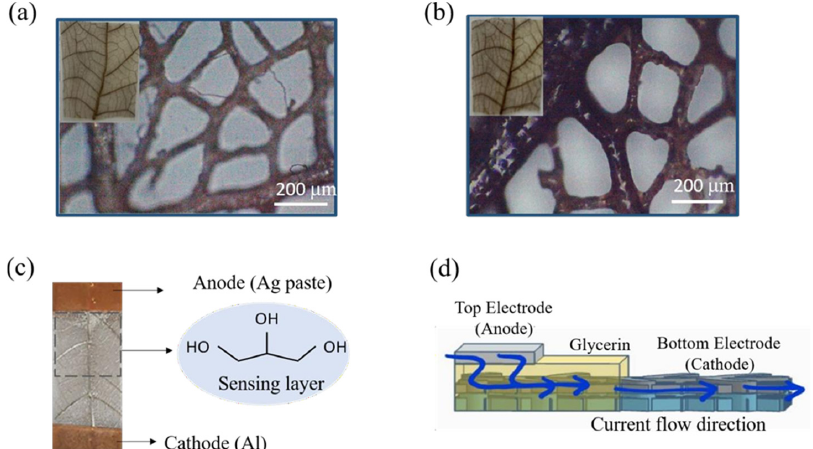
Figure 2. ( a , b ) Optical Microscopy (OM) images of the leaf vein networks before and after thermal annealing (80 °C/1 h). The inset images represent pristine leaf veins and leaf vein with sensing film (after thermal annealing). ( c ) Photo of final structure leaf vein-based sensor. ( d ) Schematic side view structure of the device and current flow direction under applied